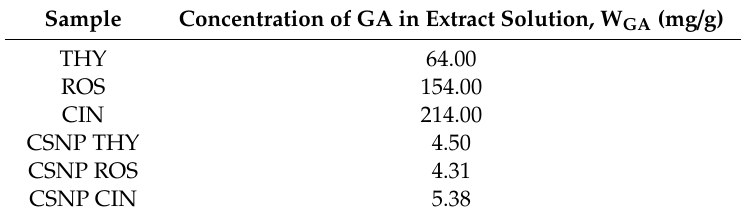
Table 3. Total phenolic content of extract solutions and chitosan nanoparticles with encapsulated